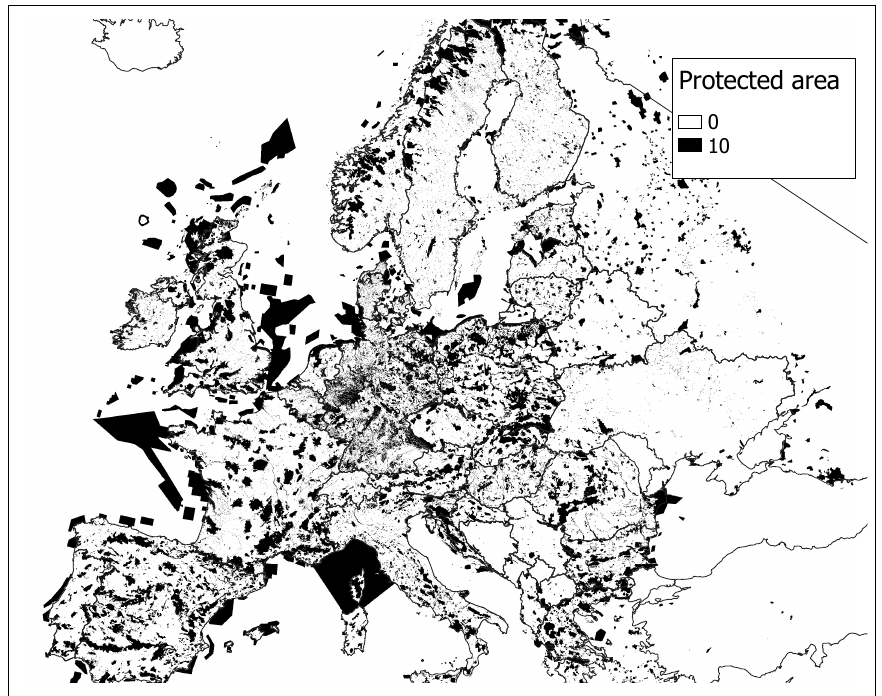
Figure 5. Geographical coverage of protected areas in Europe. Own illustration based on